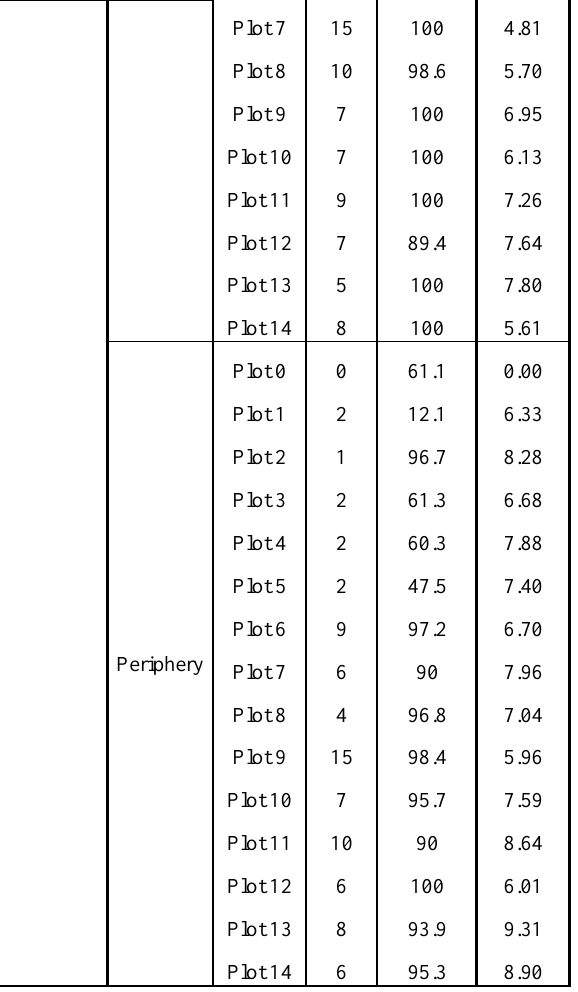
Table 4. Canopy Cover values per plot along with their corresponding field dataset.